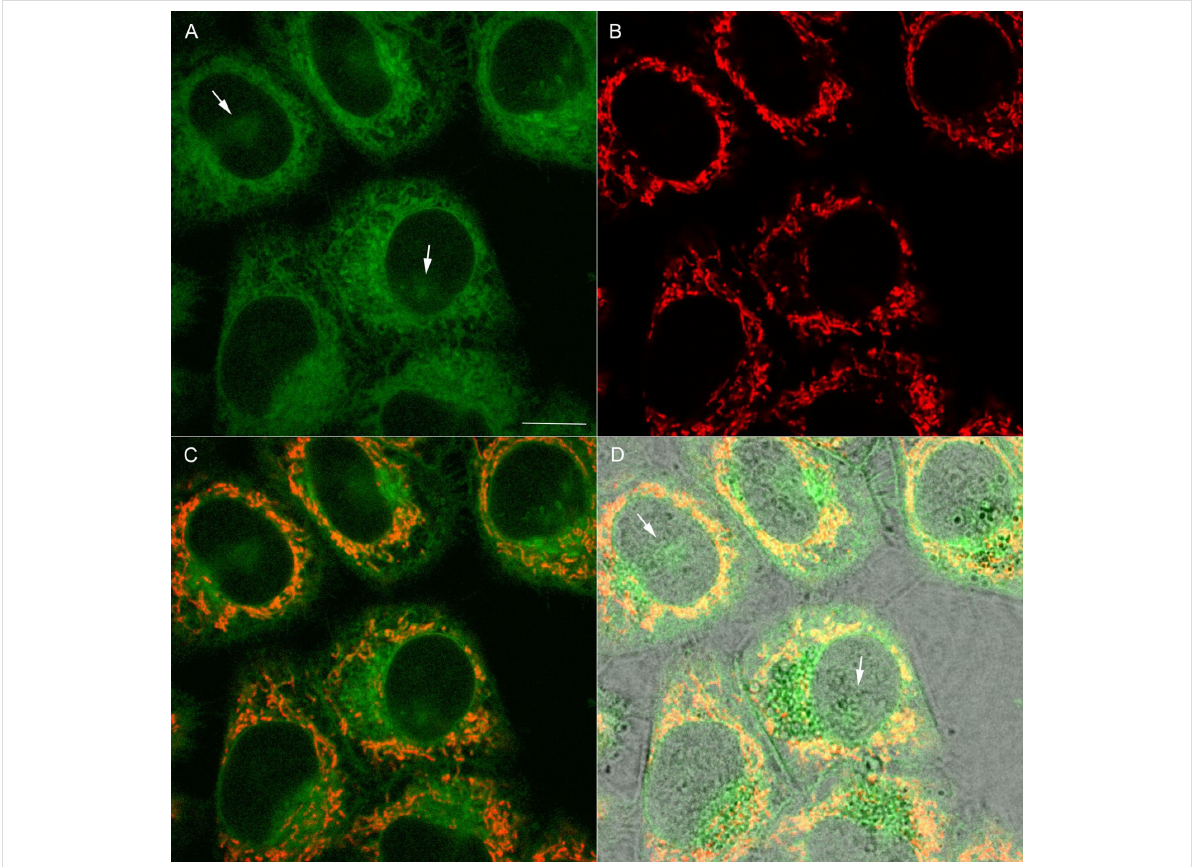
Figure 7: Cellular distribution of 5 in living HeLa cells. (A) Fluorescence of 5 (green). Arrows are marking the regions corresponding to nuclear staining. (B) Fluorescence of mitochondria-specific MitoTracker Red ® (red). (C) Merged image of 5 (green) and MitoTracker (red). (D). Merged image of (C) and transmitted light (gray). Scale bar – 10